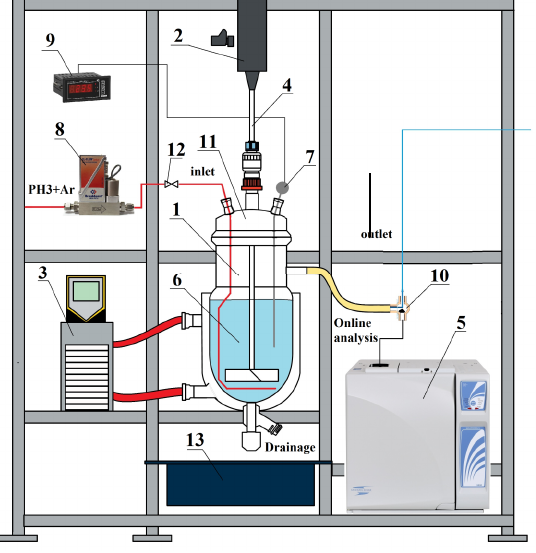
Figure 9. Scheme of a unit for oxidation of phosphine by aqueous copper–ammonia complexes. 1 —glass reactor, V = 0.2 L; 2—overhead drive motor; 3—thermostat; 4—stirrer; 5—gas chromatograph; 6—catalyst solution; 7—electrode; 8—gas flow meter; 9—ion meter and pH-meter; 10—three-way valve; 11—reactor cover; 12—faucet with sampler; and 13—pallet.